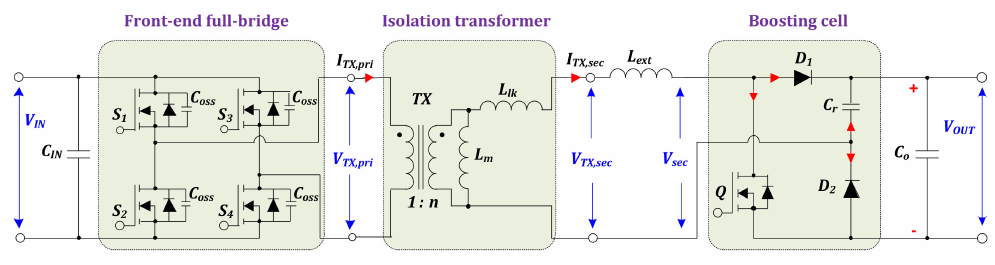
Figure 1. Configuration of the proposed topology of series resonance dc-dc converter (SRC) with a single-switch boosting rectifier